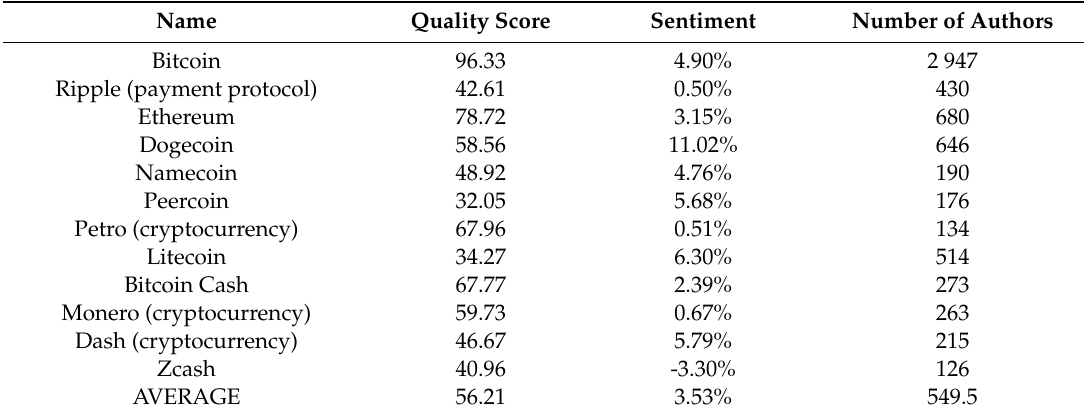
Table 6. Comparison of WikiRank quality score-based ranking, sentiment assessment and number of authors for selected cryptocurrency articles in English